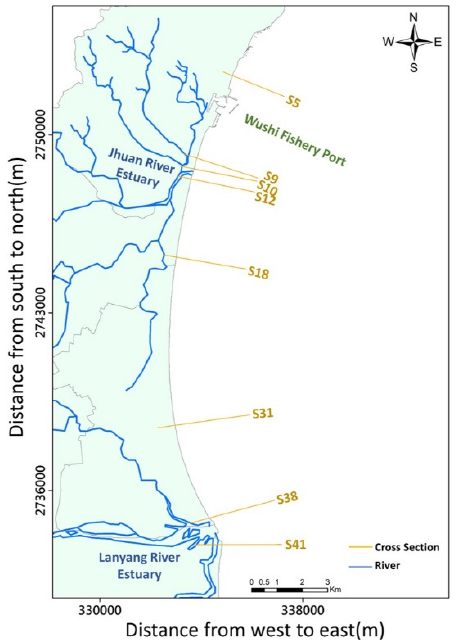
Figure 9. Spatial distribution of eight transects for the cross-shore profile comparison.